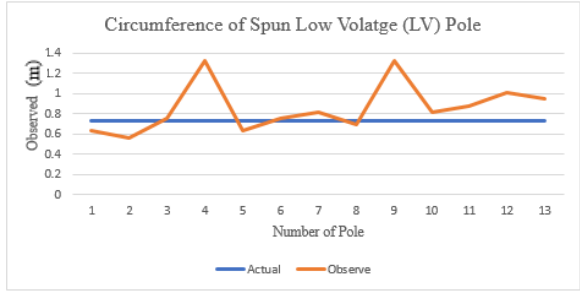
RMSE for Powerline Segment Figure 11 . The Circumference of Spun Low Voltage Pole Figure 11 shows the circumference of spun pole low voltage. Based on the graph above, the same cases as the diameter where pole number 4 and pole number 9 are also has the higher value of circumference compared to the actual value which is 1.3188m. The actual value for circumference is 0.73m.